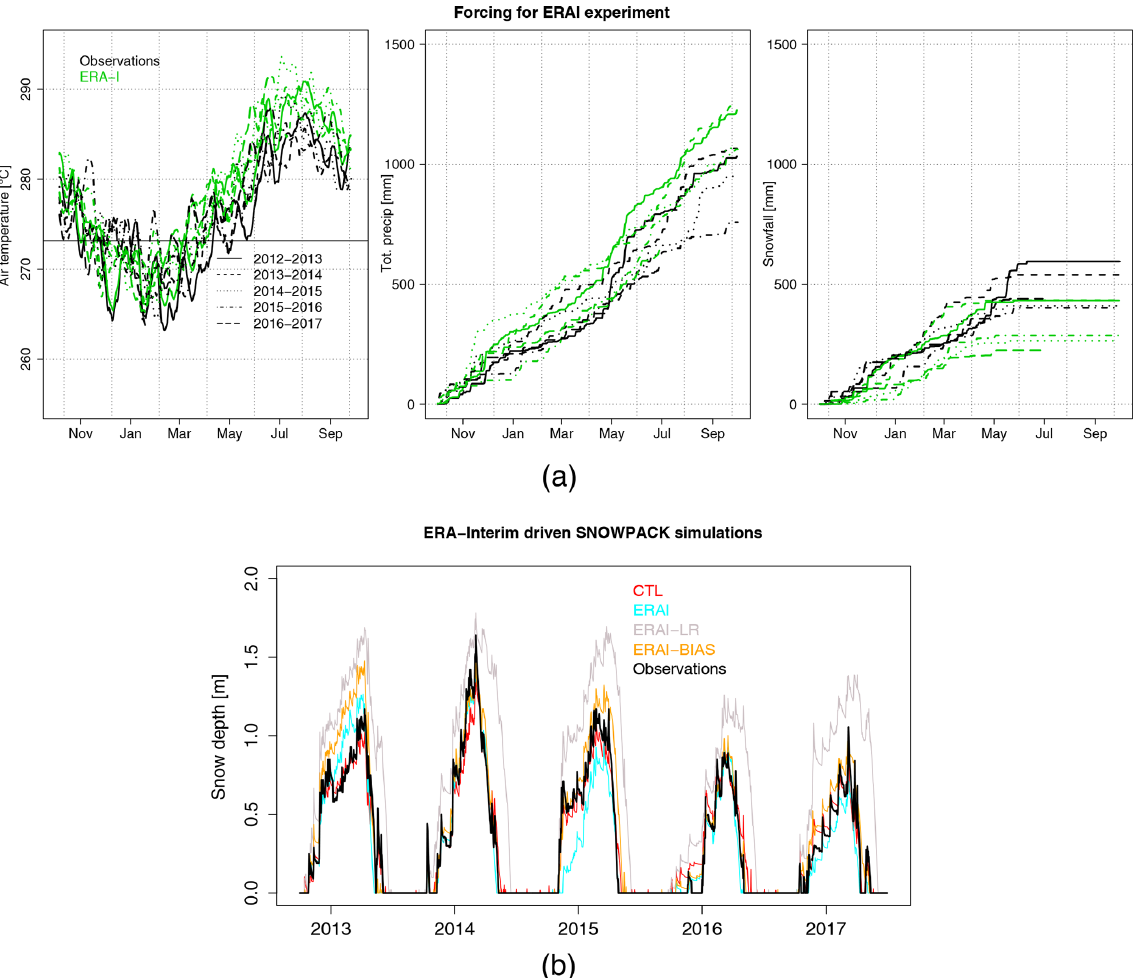
Figure 5. (a) ERA-Interim air temperature, total precipitation, and snowfall (derived as explained in Sect. 4) at the Torgnon site, compared to the station measurements (black) for each snow season of the period 2012–2017; (b) example of ERA-Interim-driven snow depth simulations (ERAI, ERA-LR, and ERAI-BIAS experiments), obtained using the SNOWPACK model, compared to CTL run and snow depth